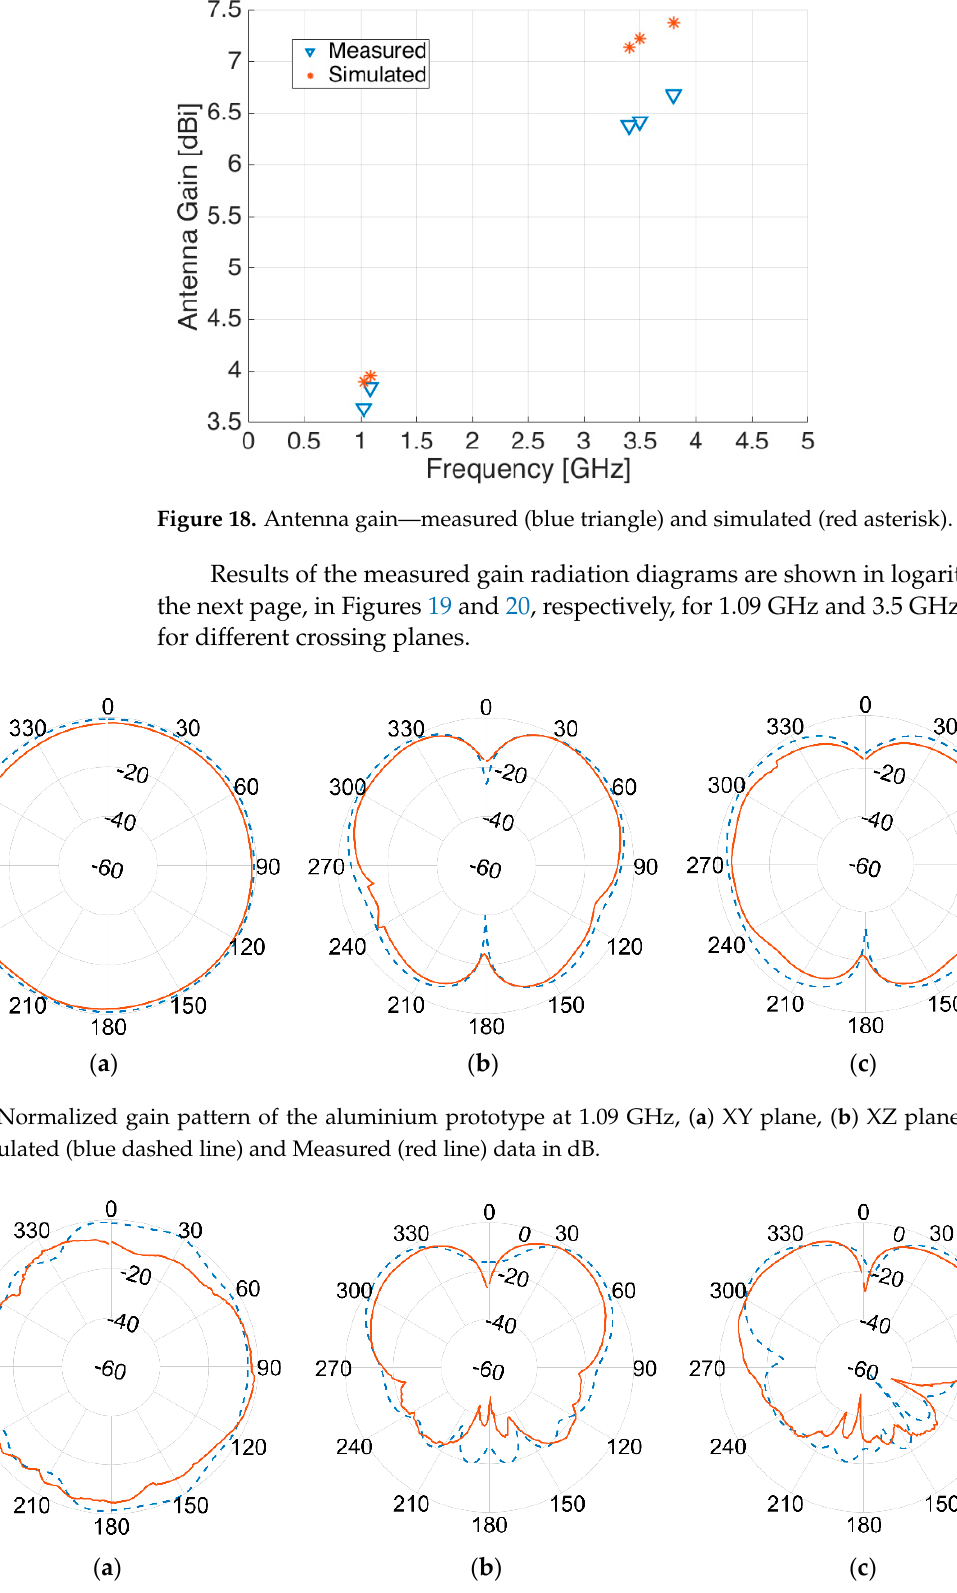
Figure 17. Reflection coefficient S 11 —measured (blue line) and simulated (red dashed line).